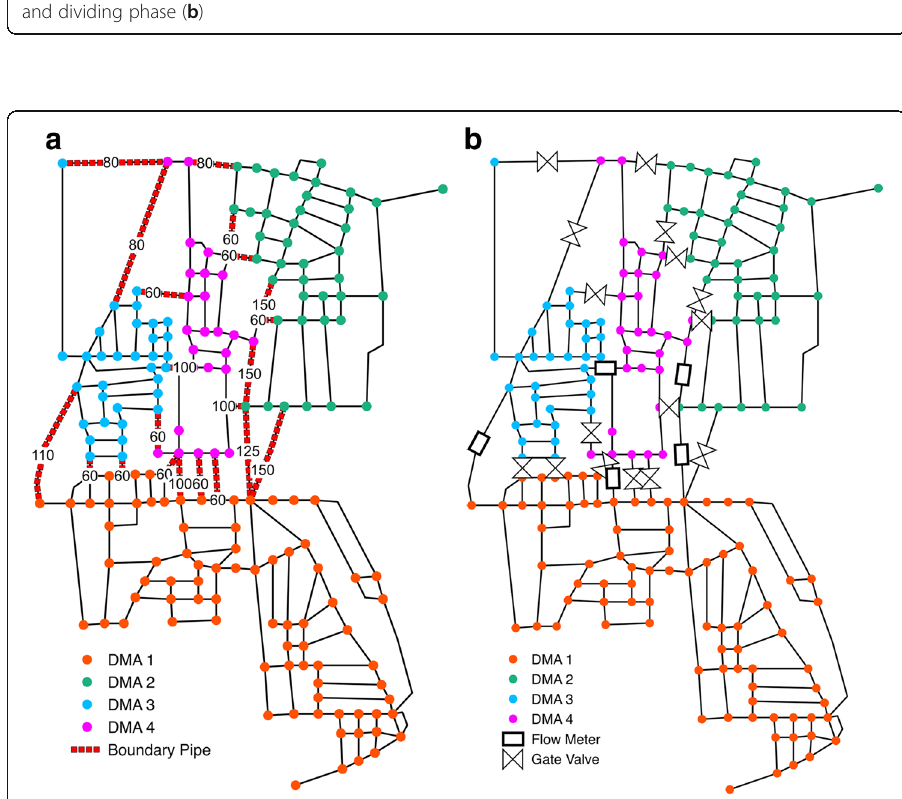
Fig. 4 Parete WSN partitioning in 4 -DMA for the conductance-weighted graph adjacency matrix and L rw Laplacian: clustering phase ( a ) and dividing phase ( b ). Flow meters are represented by rectangles while gate valves with the double